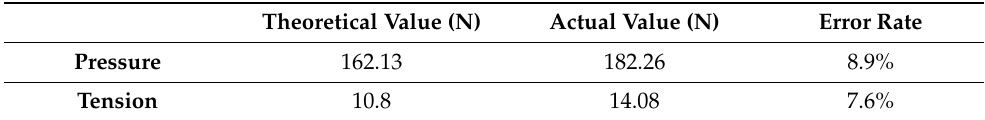
Table 3. Comparison of results.